Question: Condense the content of this figure into a single sentence.
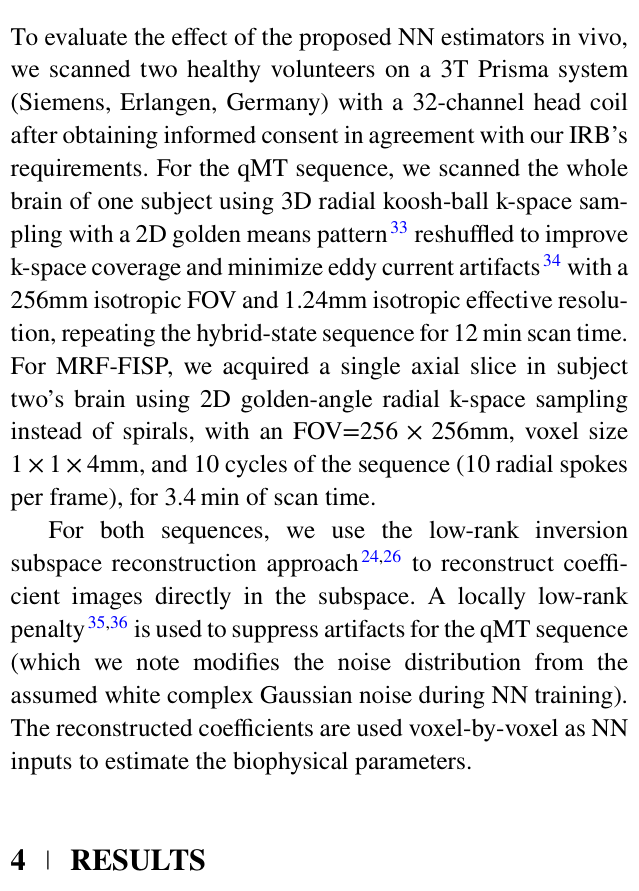
Answer: visualizes how the proposed strategy reduces the NN’s variable bias along one axis in parameter space. While the MSE-CRB NN can correctly estimate the simulated changes